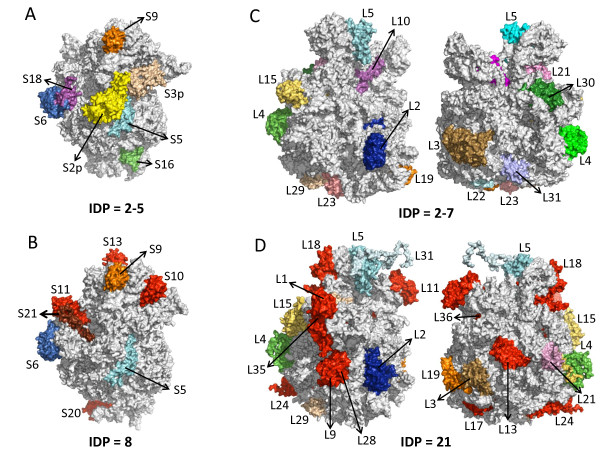
Distribution of disordered proteins on the bacterial (A,C) and chloroplast (B,D) ribosome (mapped over PDB entries 1JOO, 1VQ8, 3BBN and 3BBO, respectively). Panels A and B correspond to the 30S subunit, C and D to the 50S. Disordered proteins in bacterial ribosomal subunits are highlighted in pale yellow, pale blue, light blue, dark blue, orange, green, magenta and pink. Their chloroplast orthologues in Arabidopsis thaliana are marked in the same colour. Additional proteins found to be intrinsically disordered in chloroplast 30S and 50S subunits are highlighted in red. Numbers following S and L identify small and large subunit proteins, respectively. The disordered protein L7/L12 in the chloroplast 50S subunit is not marked because of it is absent in the structural data retrieved from the PDB. The average number of intrinsically disordered proteins (IDP) calculated for each ribosomal subunit is written below (for details see in Additional file 7: Table S6). The three-dimensional cartoons were drawn using PyMol 1.4.1 (Schrodinger LLC).